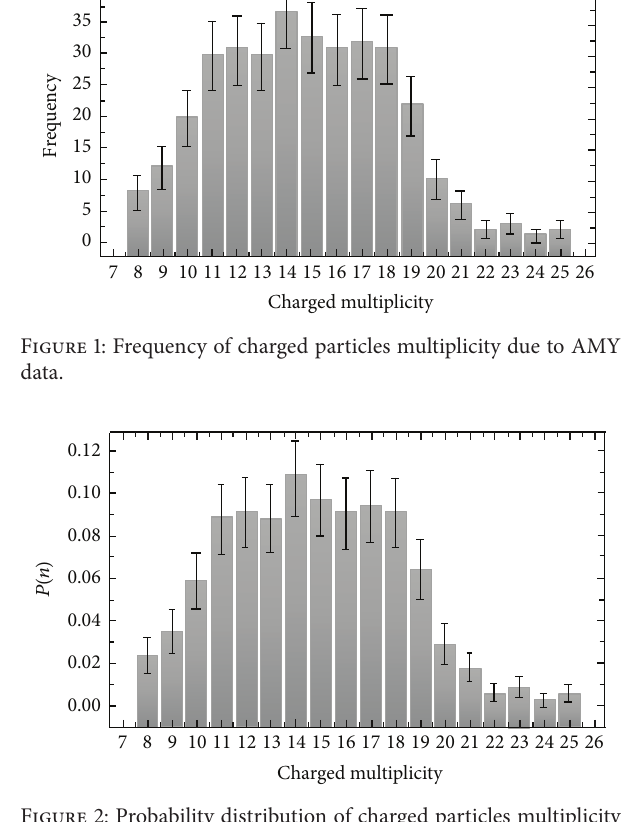
Figure 2: Probability distribution of charged particles multiplicity due to AMY data.